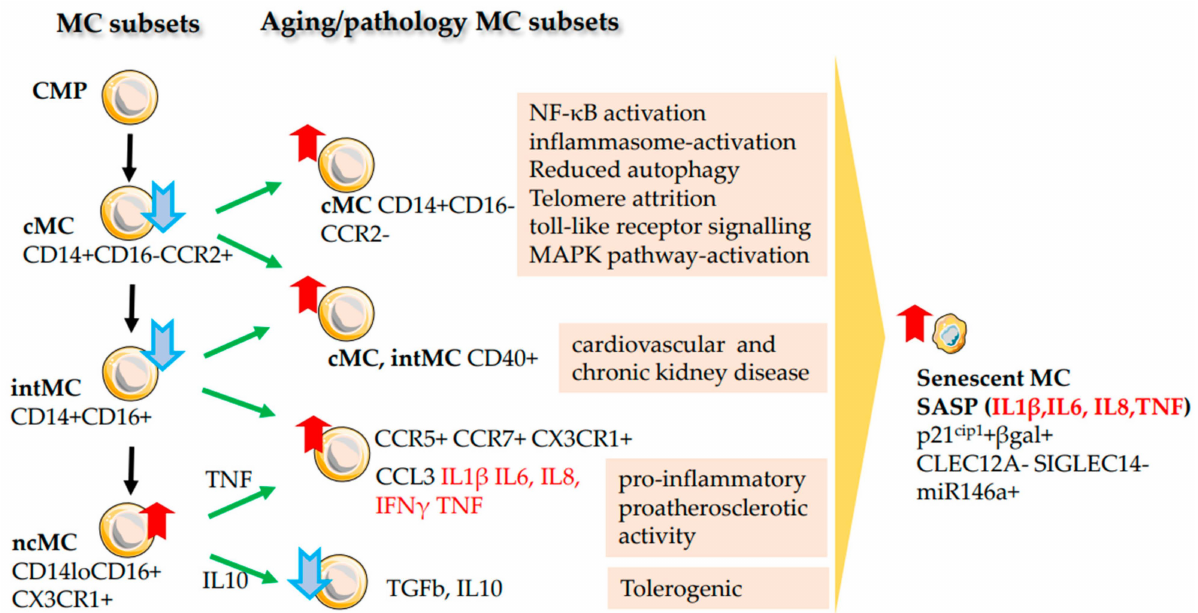
Figure 5. Ageing of Monocytes. The development of monocytes (MCs) from a common myeloid progenitor (CMP) is shown (see MC subsets). As a result of ageing, the number of classical (cMC) and intermediate MC (intMC) decreases, while the number of non-classical Monocytes (ncMC) with inflammatory profile increases. The accumulation of subsets of MC and the pathological consequences associated with aging are demonstrated on the right. For ageing intMCs and ncMCs, changes in the expression of additional cytokine receptors and pro-inflammatory factors (in red) are shown (see Aging MC subsets). The direction of MC development (black arrows) and possible ways of MC ageing (green arrows) are indicated. The increase in MC populations (red arrow pointing up), and the decrease (blue arrow pointing down) are shown. Age-related accumulation of senescent MCs (red arrow), senescence-associated secretory phenotype (SASP) and typical markers of senescent MCs are demonstrated on the